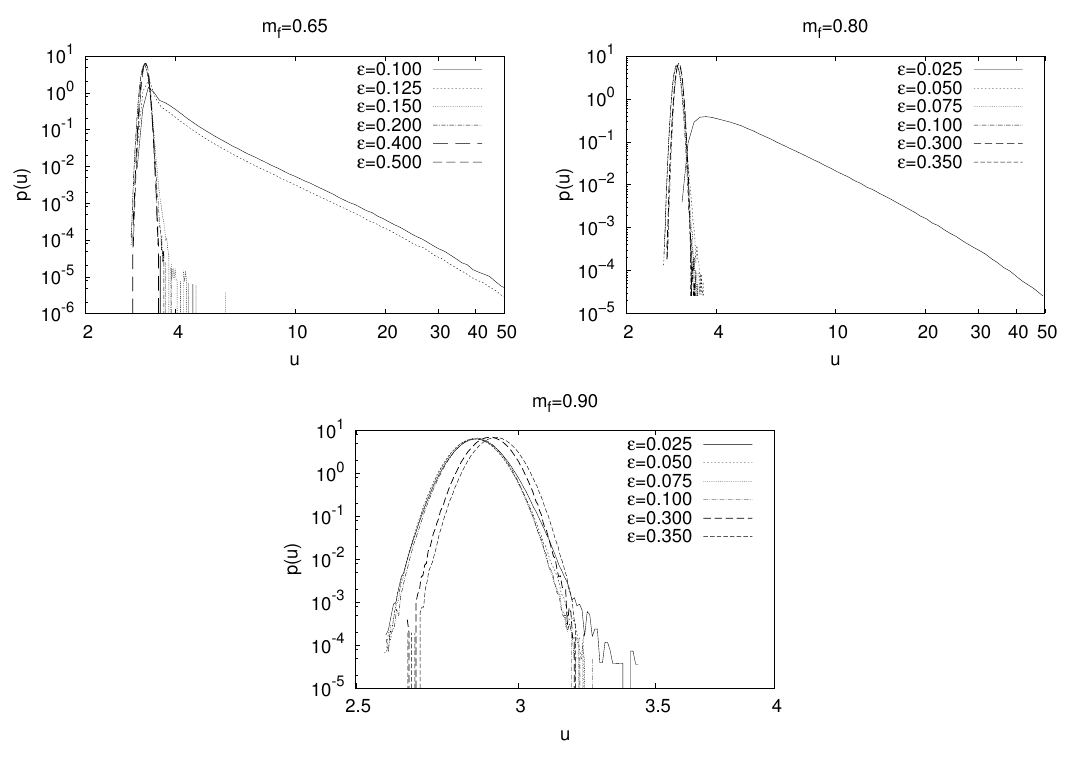
is a kind of mass term, which breaks the SO(6) symmetry minimally to SO(5). We